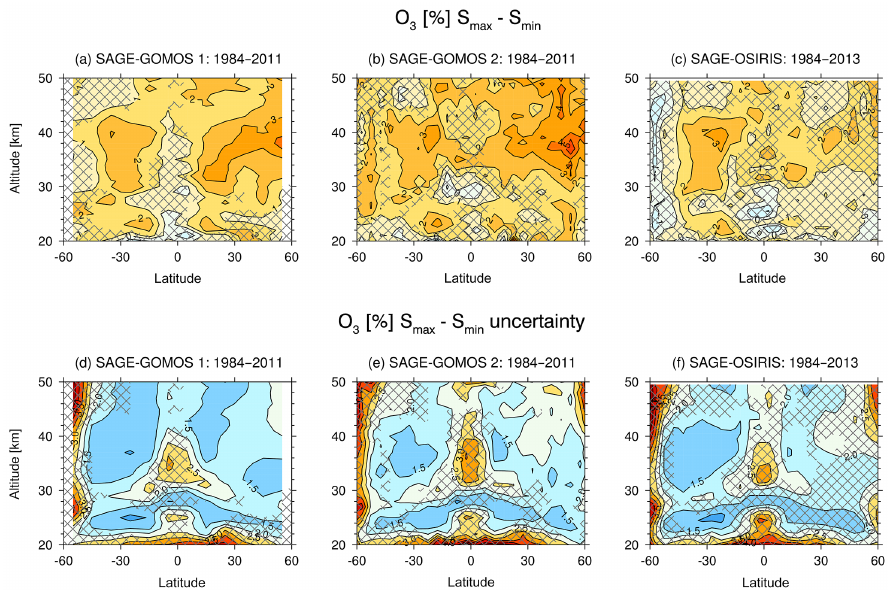
Figure 10. (a–c) As in Fig. 4 but for the extended SAGE II number density datasets: (a) SAGE–GOMOS 1, (b) SAGE–GOMOS 2, and (c) SAGE–OSIRIS. SORs are derived for different periods as stated in the headers. The contour interval is 1%. (d–f) As in Fig. 5 but for the datasets as shown in panels (a–c) . The contour interval is 0.5%. The hatching is as in Fig.